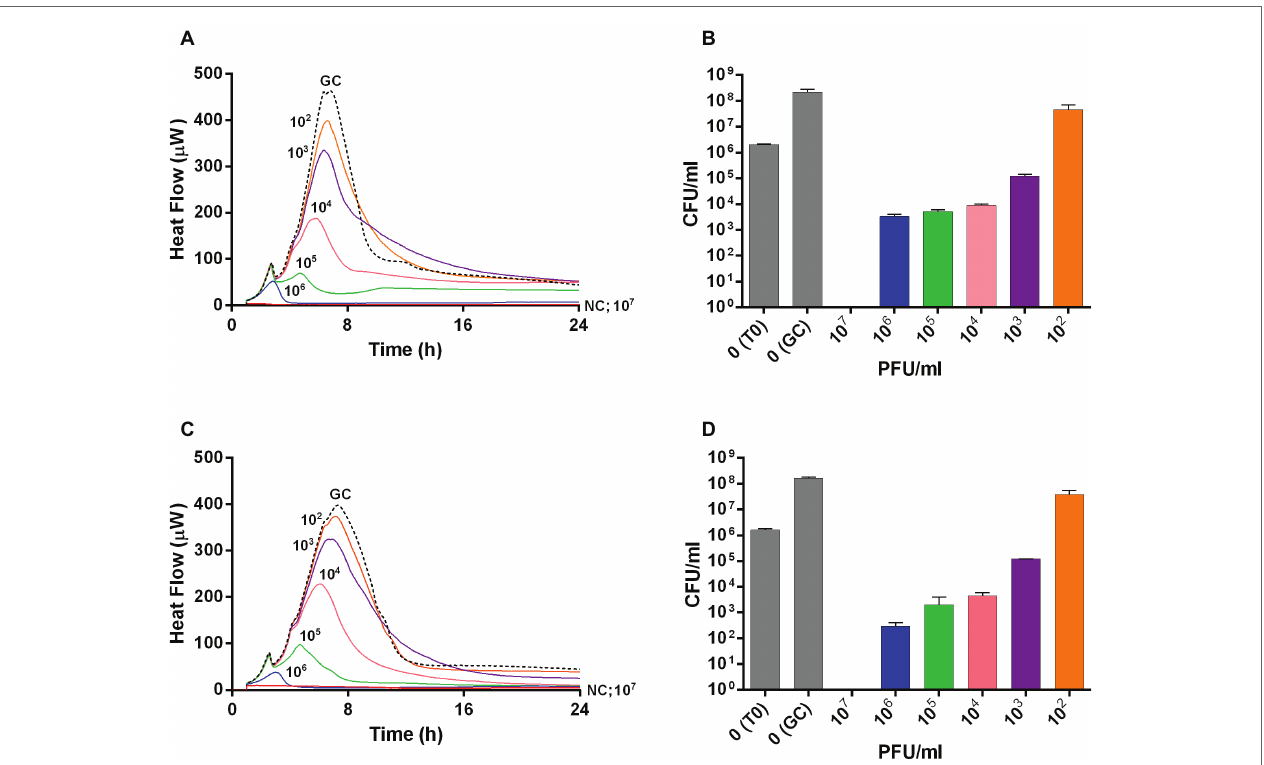
FIGURE 1 | Evaluation of MRSA ATCC43300 susceptibility to Sb (A,B) and PYO (C,D) exposure, by isothermal microcalorimetry (A,C) and colony counting (B,D) . Each curve shows the effect of different titers of phages on the heat produced by viable bacteria during 24 h of treatment with Sb (A) and PYO (C) . Histogram represents the mean of CFU number ± SEM of planktonic MRSA treated/untreated with Sb (B) and PYO (D) . Numbers above curves represent Sb titers (PFU/ml). GC, growth control (dashed line); NC, negative control; T0, initial